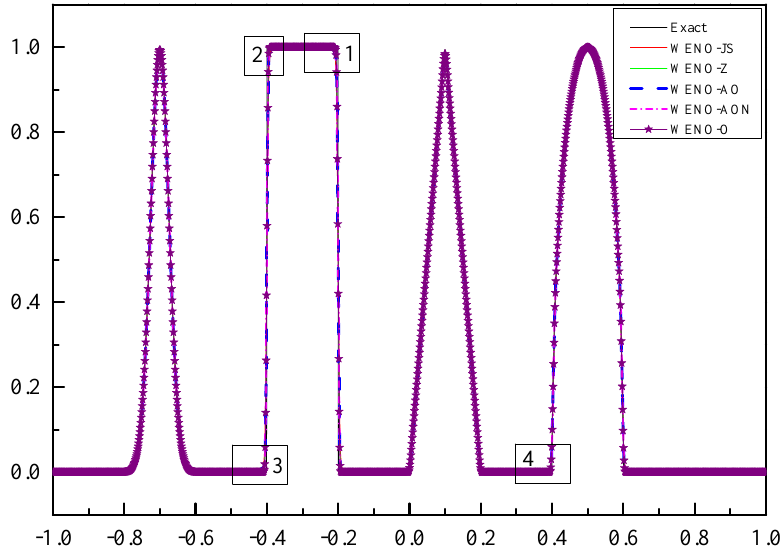
Figure 8. Numerical solutions of Example 3 (Section 6.1.3) on 1600 cells at t = 10 and CFL =